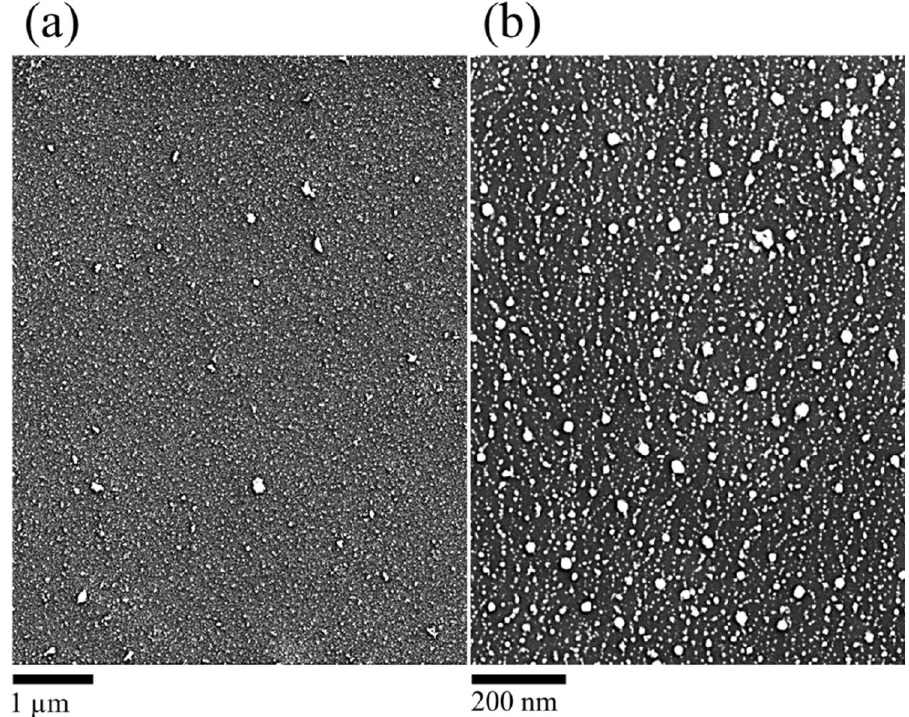
Figure 8. SEM images showing surface nanofeatures of Si, covered with silver nanoparticles using a helium plasma jet, launched in the reversed mode by setting the live electrode downstream and ground upstream of the reactor while the rest of the plasma conditions